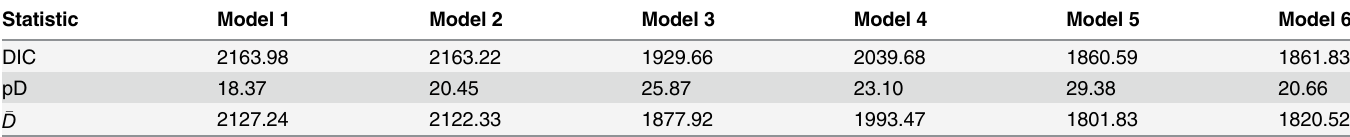
Table 3. Models comparison based on the DIC